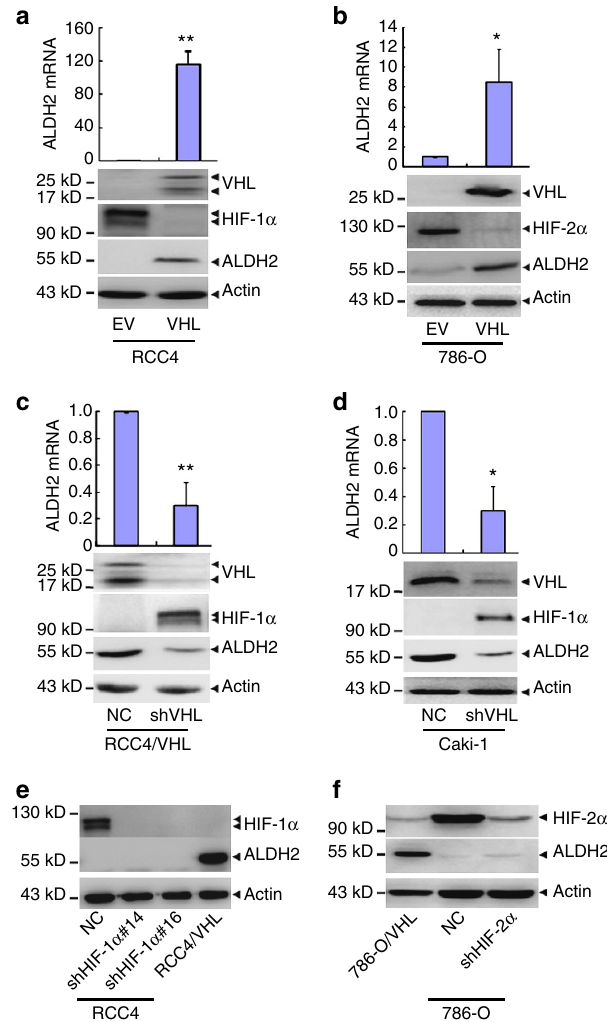
Figure 6 | VHL regulates ALDH2 in a HIF-independent manner. ( a – f ) The mRNA and/or protein levels of the indicated genes were detected by real- time quantitative RT–PCR and western blot respectively. Actin was used as the loading control. RCC4 cells ( a ) and 786-O ( b ) were stably transfected with VHL expression vector (VHL) or empty vector (EV). RCC4/VHL ( c ) and Caki-1 cells ( d ) were infected with retroviral vectors harbouring shRNA against VHL (shVHL) or non-specific control (NC). ( e ) RCC4 cells were stably transfected with shRNAs against HIF-1 a ( a 14 and a 16). ( f ) 786-O cells were infected with retroviral vectors harbouring shRNA against HIF-2 a (shHIF-2 a ) or non-specific control (NC). Columns, means of